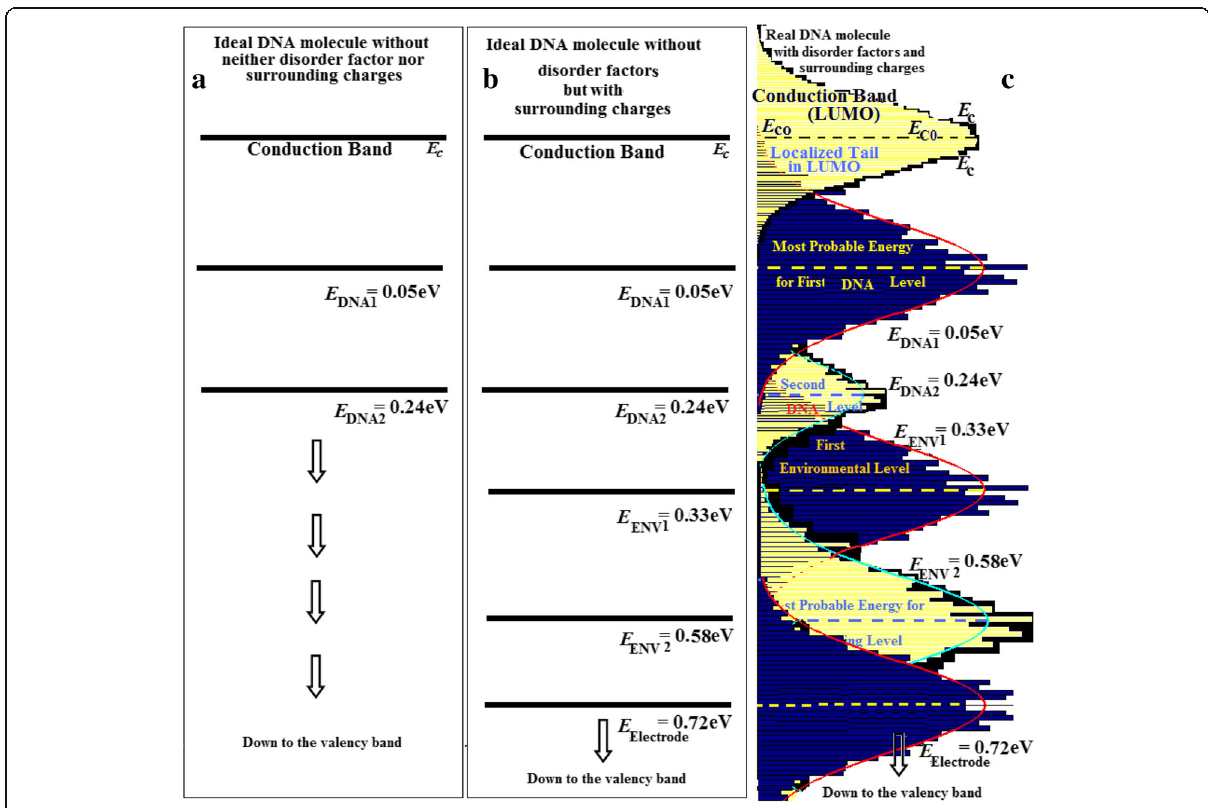
Fig. 1 a Ideal DNA sample without disorder factors and without surrounding charges. b Illustrates an ideal n-type semiconductor DNA sample without disorder factors but it has surrounding charges. c represents a real n-type semiconductor DNA sample with both disorder factors and surrounding charges. They are five trapping levels lying above the valence band. One will denote them H1, H2, H3, H4, and H5. Note that this figure represents ideal n-type semiconductor, and the same assumptions are valid for p-type